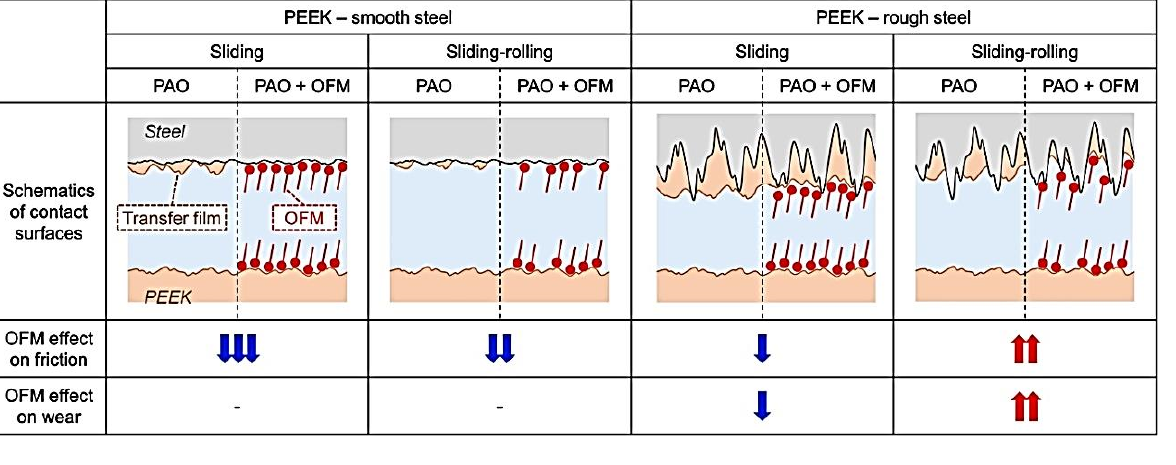
Figure 6. The OFM lubrication mechanism in the PEEK-steel contacts. Figure is reproduced with permission from reference [29].